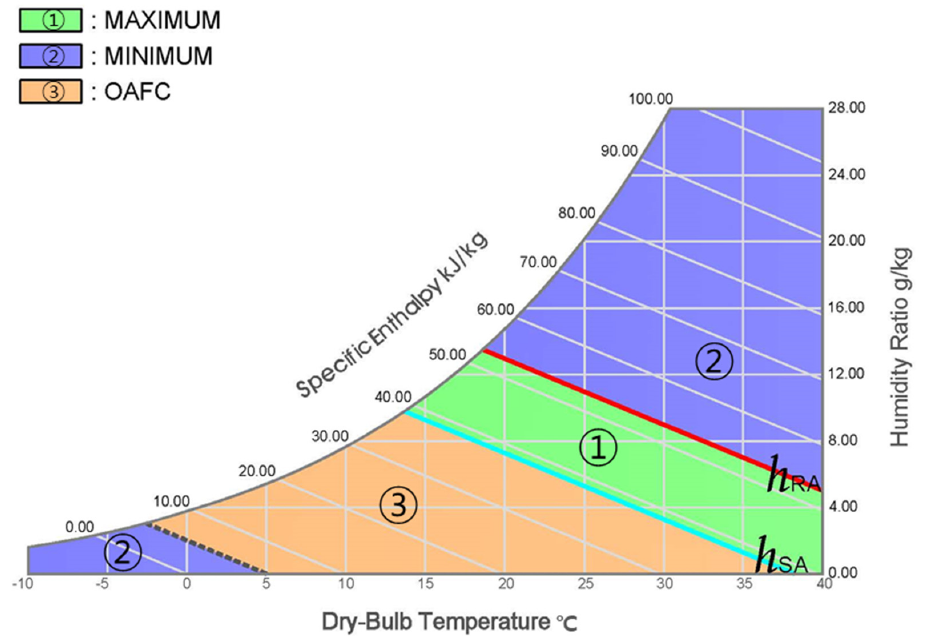
Figure 3. Di ff erential enthalpy control Figure 3. Differential enthalpy control method. Figure 3. Differential enthalpy control method.